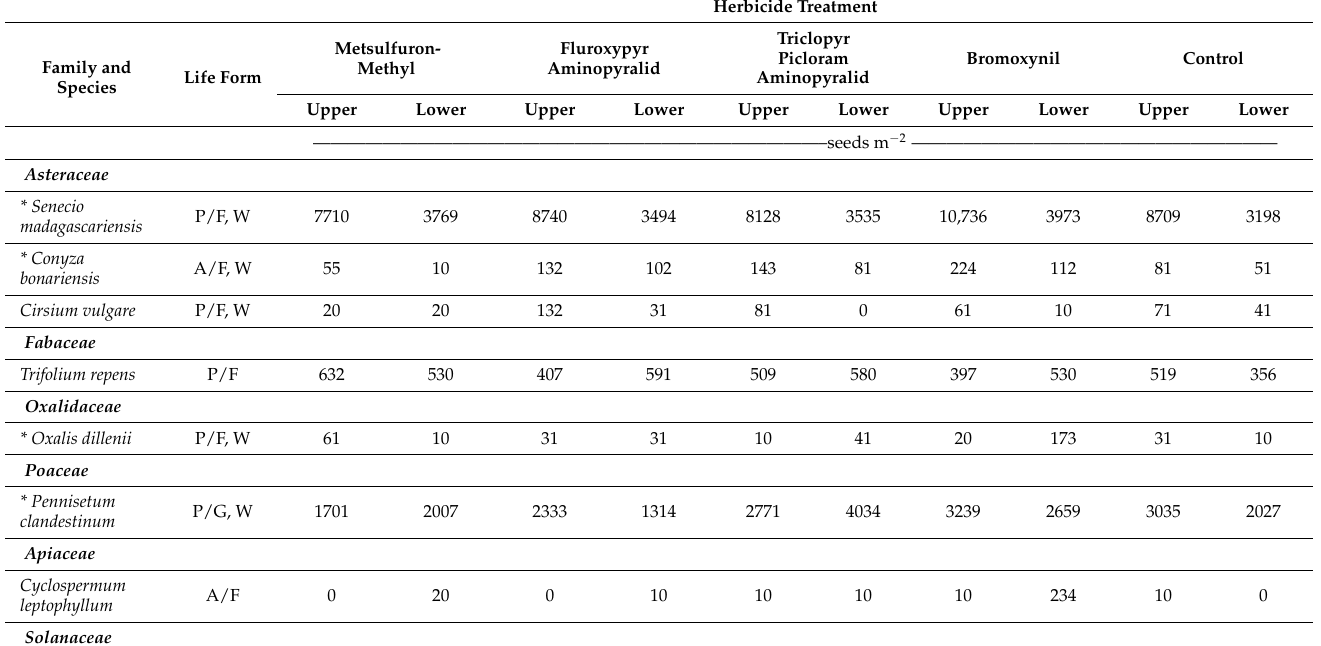
Table 1. Germinable soil seed bank species seed density of a fireweed-dominated kikuyu pasture at Beechmont, Queensland, before the application of metsulfuron-methyl, fluroxypyr/aminopyralid, triclopyr/picloram/aminopyralid or bromoxynil, compared with a non-treated control, at two soil depths: upper (0 to 2 cm deep) and lower (2 to 10 cm